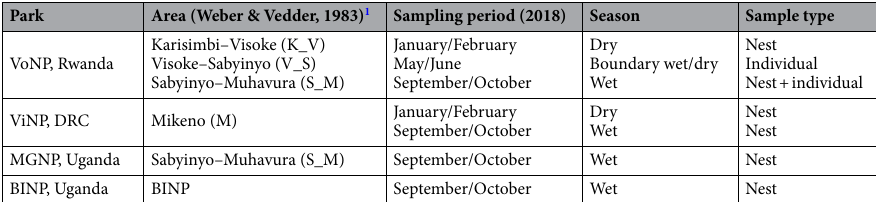
Table 1. Sampling design by area (with a national park and country), sampling period and its corresponding season and sample type (for more detailed information about sampled groups, see the Supplementary Table S1). VoNP Volcanoes National Park in Rwanda, ViNP Virunga National Park in Democratic Republic of the Congo, MGNP Mgahinga Gorilla National Park in Uganda, BINP Bwindi Impenetrable National Park in